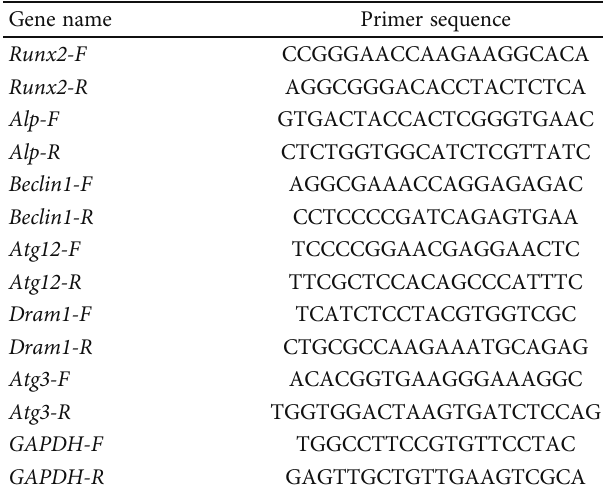
Table 1: Primer sequences for